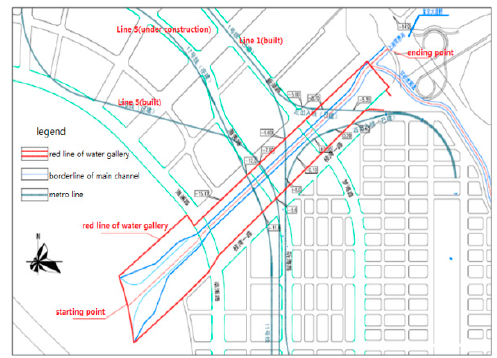
Figure 2. Relationship between waterways and subway lines.